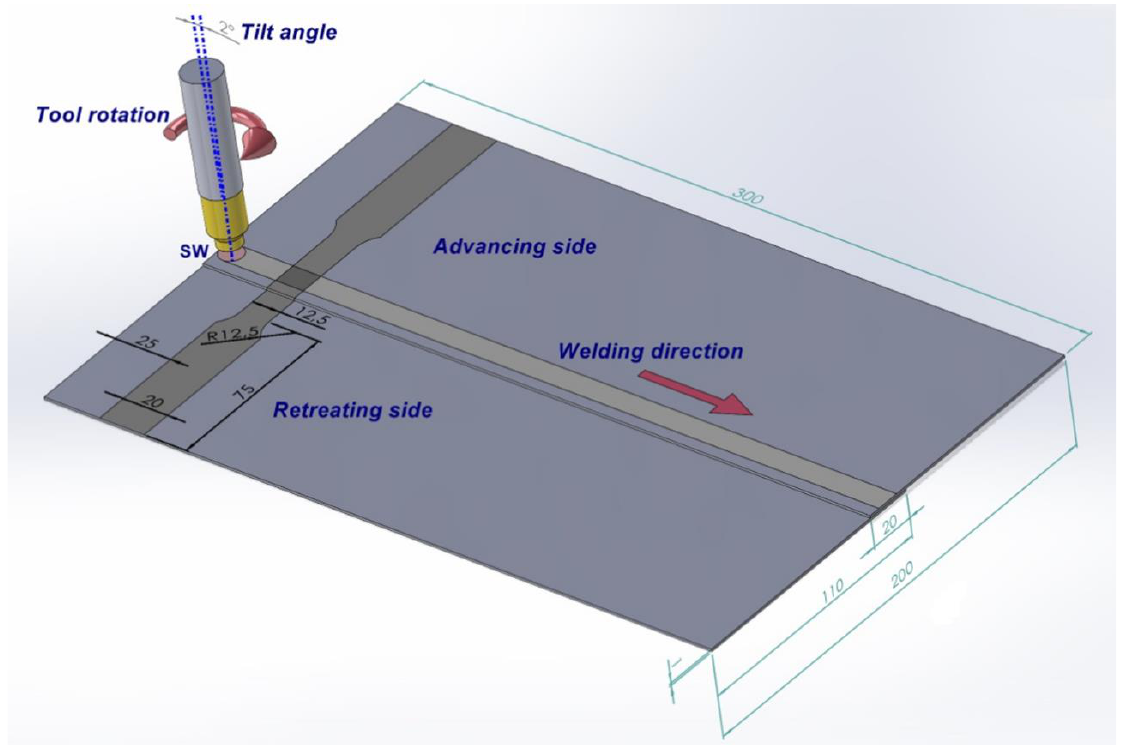
Table 2. Basic mechanical properties of the EN AW-2024-T3 aluminium alloy [44]. Yield Stress R p0.2 ,